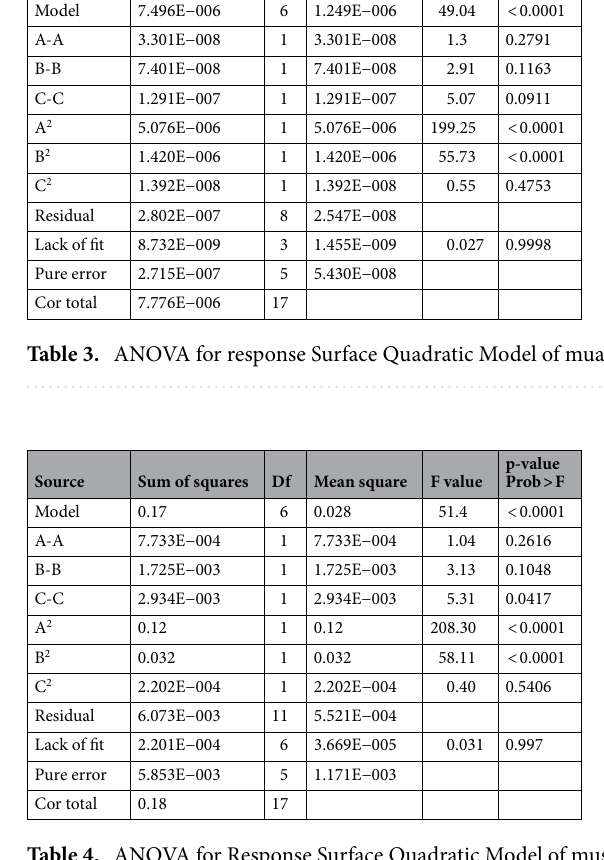
Table 4. ANOVA for Response Surface Quadratic Model of mus.